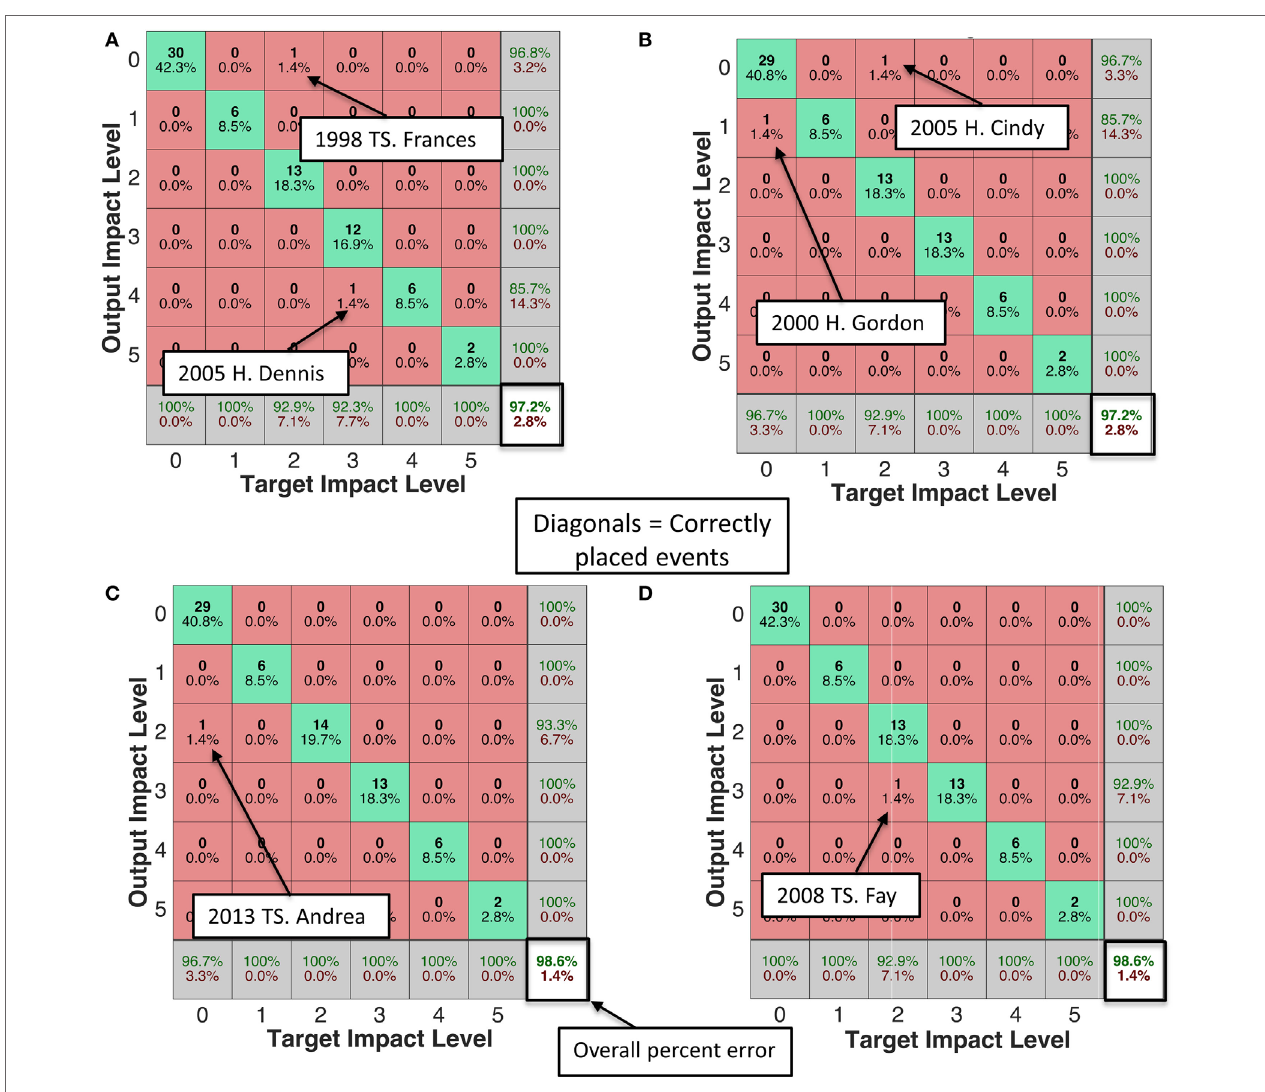
FigUre 5 | Storm event placement in building HIL Models (a) 2016e, (B) 2016g, (c) 2016h, and (D) 2016i (H = hurricane, TS = tropical